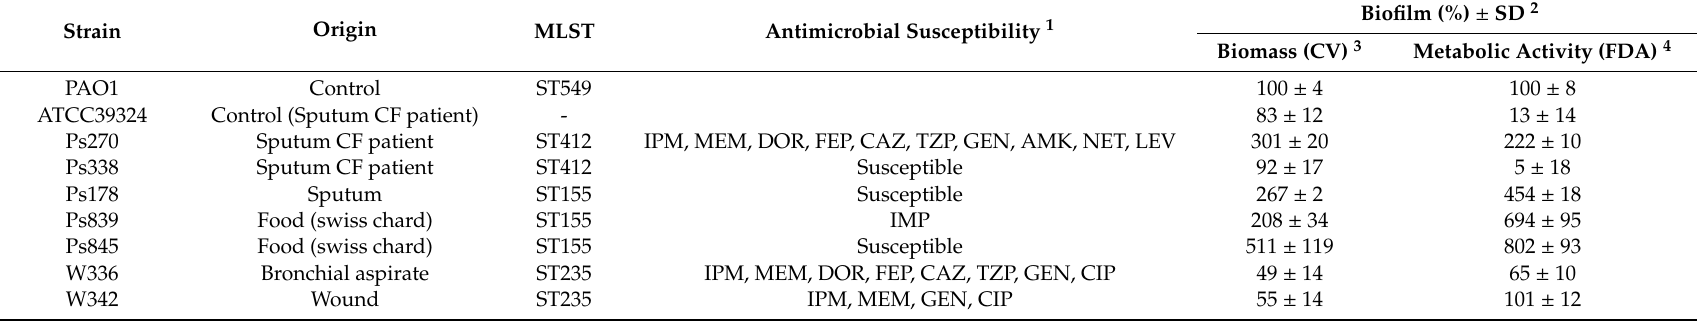
Table 5. Information about the seven clinical and non-clinical P. aeruginosa strains, and the P. aeruginosa PAO1 and ATCC39324 control strains selected for this study.